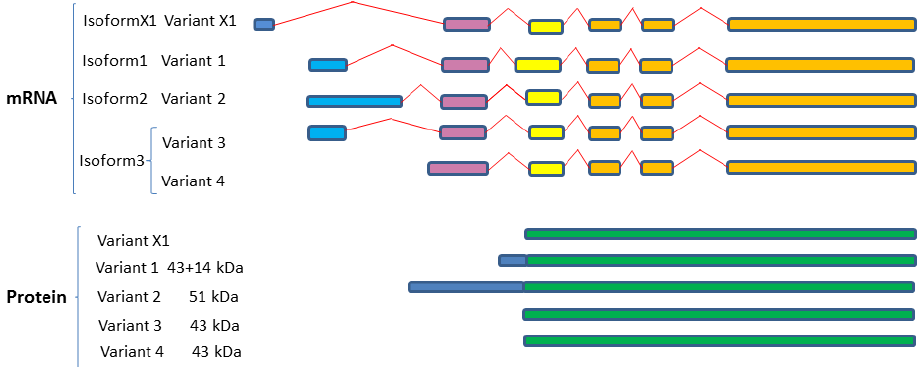
Figure 3. Variant splicing and dicing of human SphK1 isoforms. Schematic diagram of SphK1 splice variants and protein isoforms based on mRNA and protein sequences acquired from GenBank. Colored boxes are representative of different RNA fragments and protein fragments, same color boxes are originated from the same origin of DNA sequences and are identical/similar sequences. Expression from four variant mRNA transcripts (variants 1–4) results in three SphK1 isoforms (isoforms 1–3). A predicted fifth human SphK1 splice variant (variant X1), based on sequence prediction methods, results in a predicted fourth isoform (isoform X1) (annotated using gene prediction software and further evidenced by mRNA and EST). SphK1 sequences were aligned using Clustal Omega (V1.2.4) multiple sequence alignment (Available online: